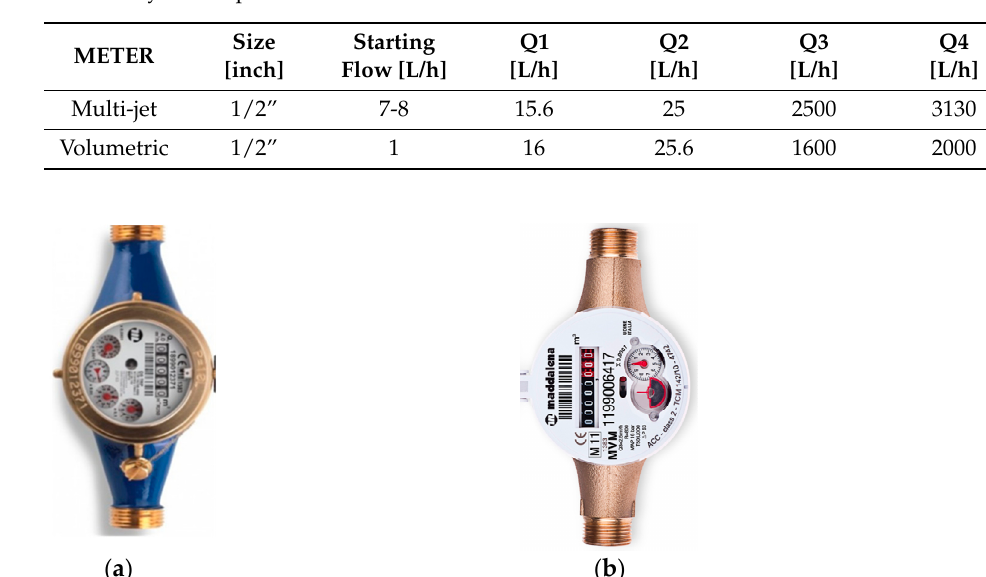
Table 2. Hydraulic performance of water meters.